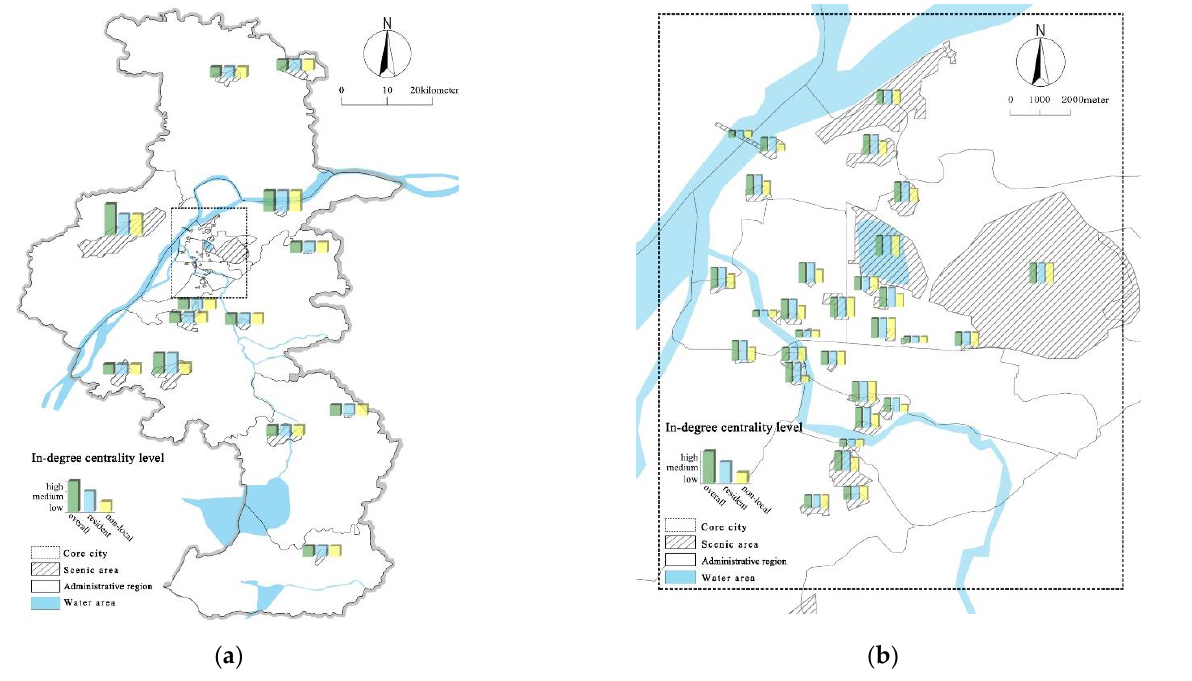
Figure 5. Classification map of the in-degree centrality of nodes under three types of network context (overall, resident, and non-local tourist): ( a ) entire city of Nanjing; ( b ) core city of